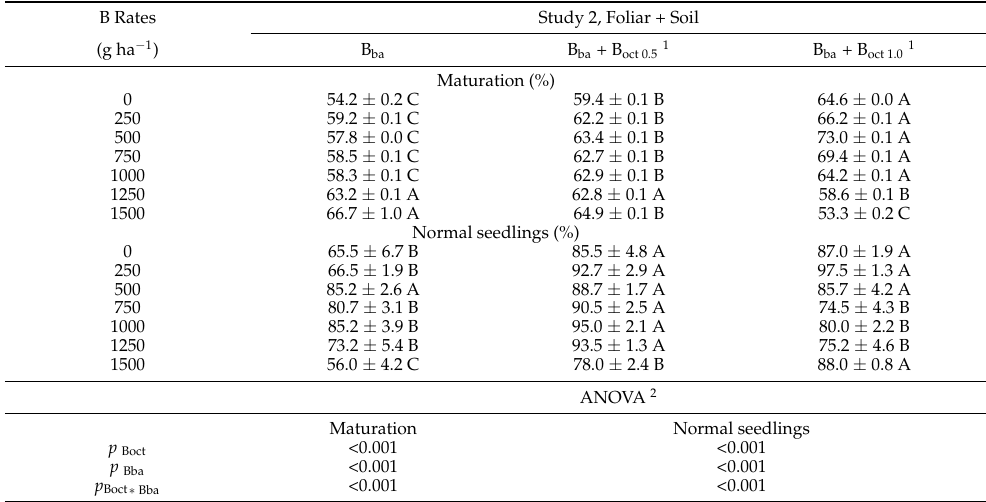
the LSD test (B sources) and the Regression test (B rates) at a confidence level of 0.01. The interaction was tested by the application of monoethanolamine (foliar) and sodium octaborate (soil). Averages of B sources with significant results were represented by different uppercase letters (A, B and C). Averages presented with error variation. Table 5. Maturation (%) and normal seedlings (%) in Study 2 with B application in soil using sodium octaborate (Boct) with two rates (Boct0.5: 0.5 kg ha − 1 ; and Boct1.0: 1.0 kg ha − 1 ), and the foliar B application using boric acid (Bba) with six rates (250, 500, 750, 1000, 1250, and 1500 g ha − 1 ).